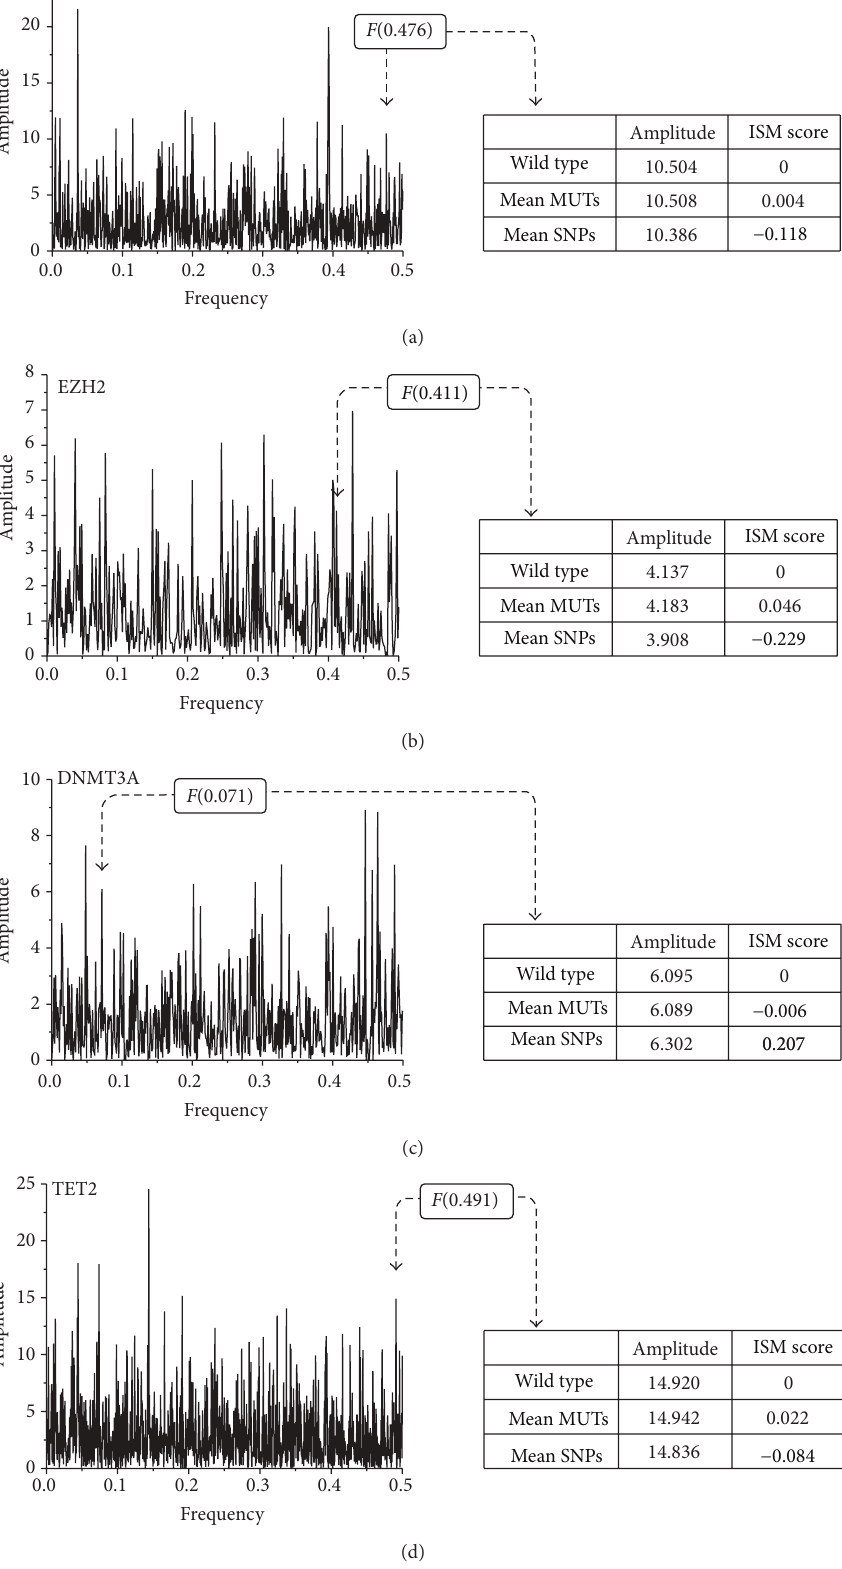
Figure 3: Process for the selection of significant frequencies from the spectra of ASXL1 (a), EZH2 (b), DNMT3A (c), and TET2